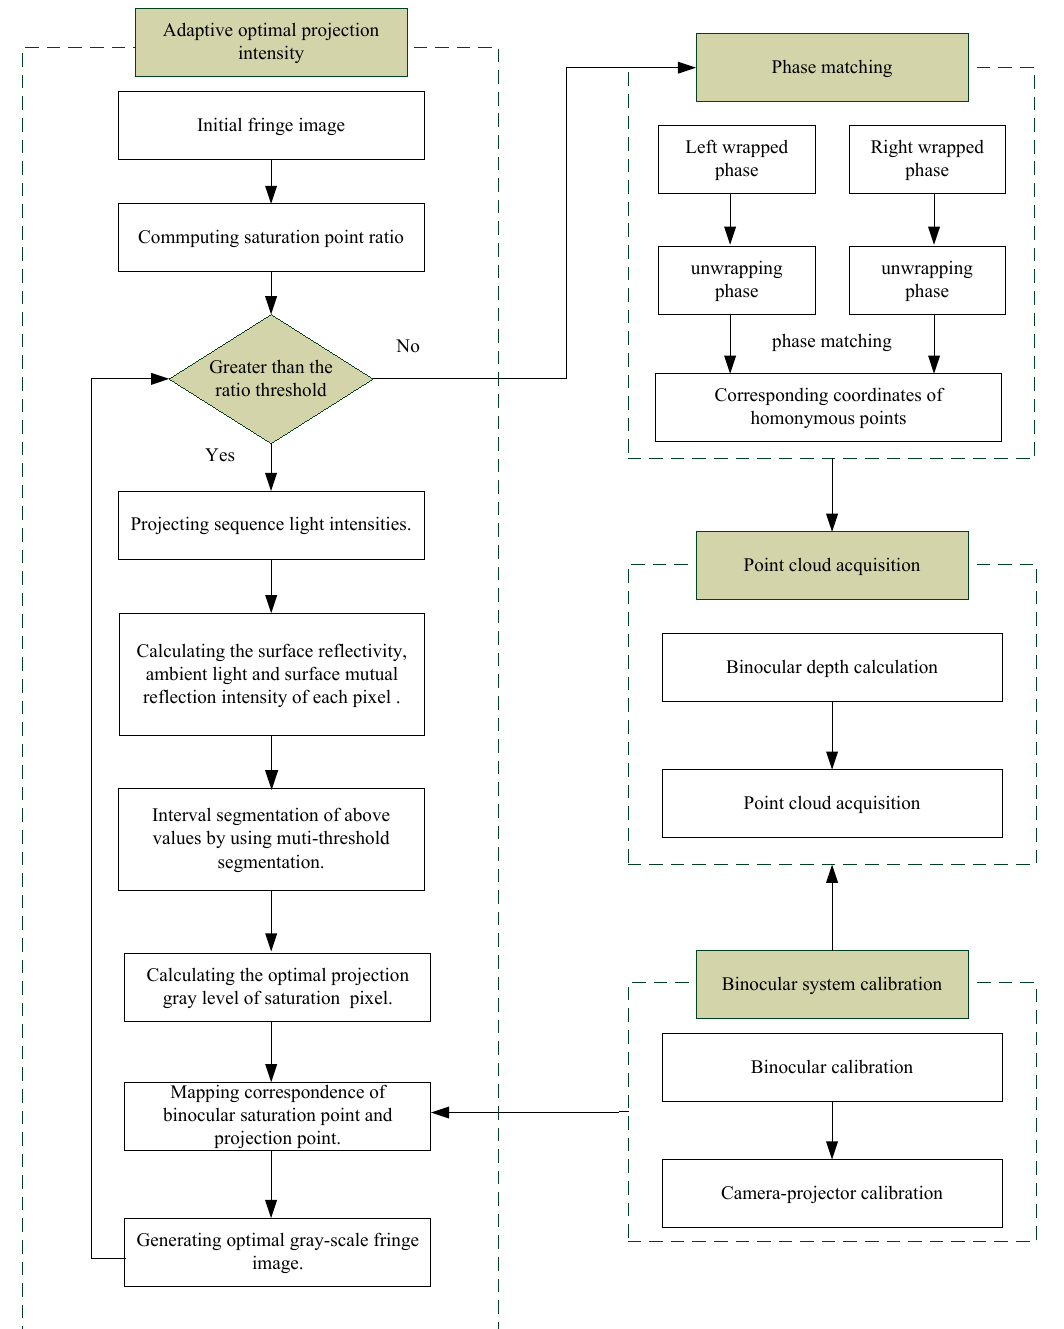
Figure 1. Flowchart of the adaptive binocular fringe dynamic projection method (ABFDP) method.